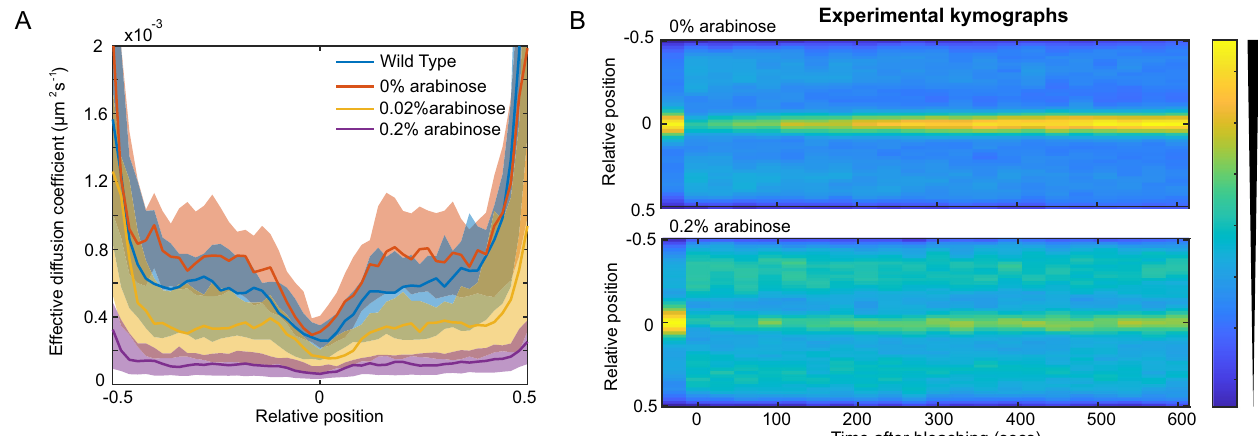
Fig 6. Increasing the concentration of TolA lowers the effective diffusion coefficient of Pal. (A) The effective diffusion coefficient of Pal-mCherry in dividing cells for wild type and at different levels of tolA expression. As the concentration of arabinose increases the effective diffusion coefficient of Pal decreases. Shown is the median and 95% confidence intervals from approximately 30 cells for each case. (B) Averaged kymographs of FRAP on Pal-mCherry (data as in (A)) for 0% (top) and 0.2% (bottom) arabinose induction. While the septal signal recovers fully by 10 min at 0% arabinose, it only partially recovers for 0.2% arabinose. See also S6